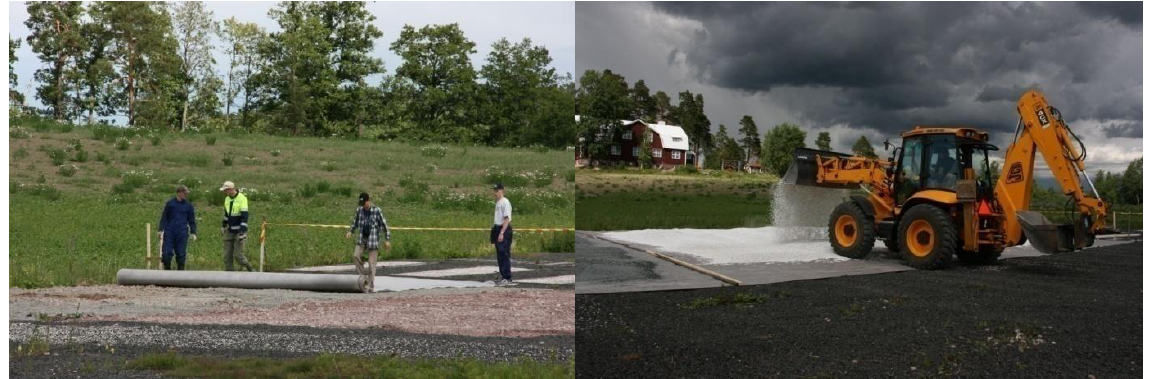
Figure 3. Construction of a test field of gravel. The root blocking carpet is installed (left) and a 5–10 cm layer of gravel spread over it